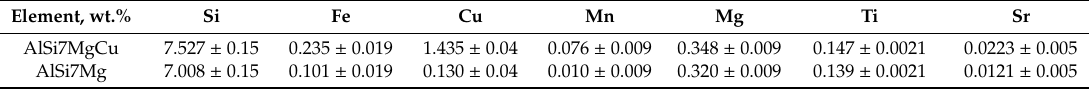
Table 3. The chemical compositions of AlSi7MgCu / AlSi7Mg